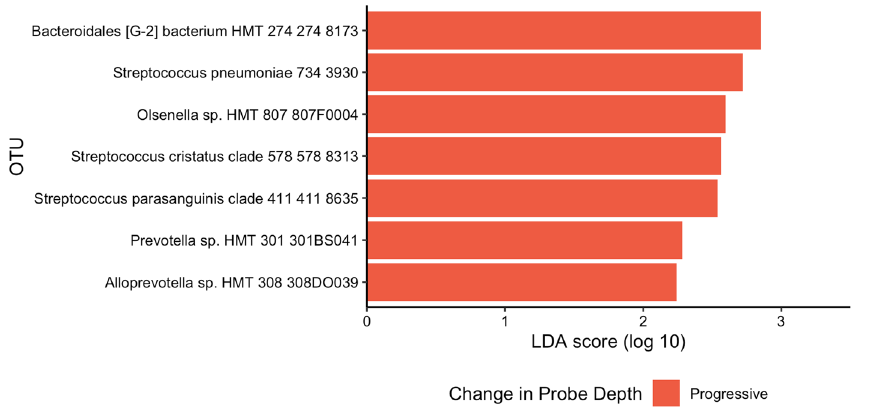
Figure 5. OTUs associated with changes in probing depths determined using linear discriminant analysis Effect Size (LEfSe). Five different subjects were represented in eight progressing sites, with subjects CC, VJ, and WH each contributing two sites. One progressed site was excluded (WH13) due to the lack of a match with a similar (within 1 mm) baseline probing depth in that subject. Color represents enrichment of the OTU associated with changes in probing depths at subgingival sites. OTUs with an LDA score greater than 2 are shown. Sites were classified as progressing if the probing depth increased by 2 mm or more over 6 months. The probing depth for stable sites had no changes over 6 months. Baseline samples of progressing sites were matched to all clinically stable sites with similar (+ /− 1 mm) baseline probing depths within the same